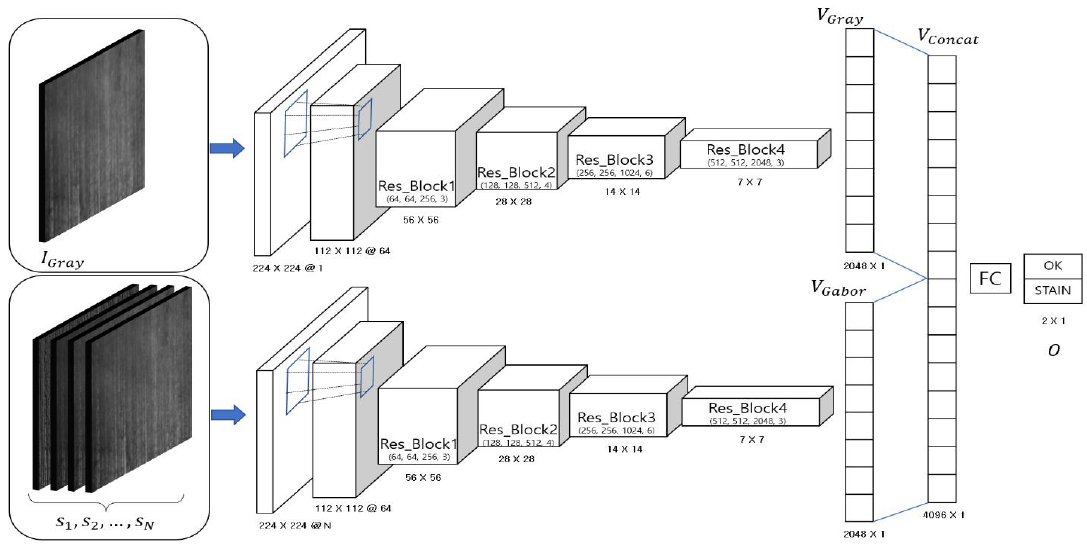
Figure 5. Dual-stream network structure based on